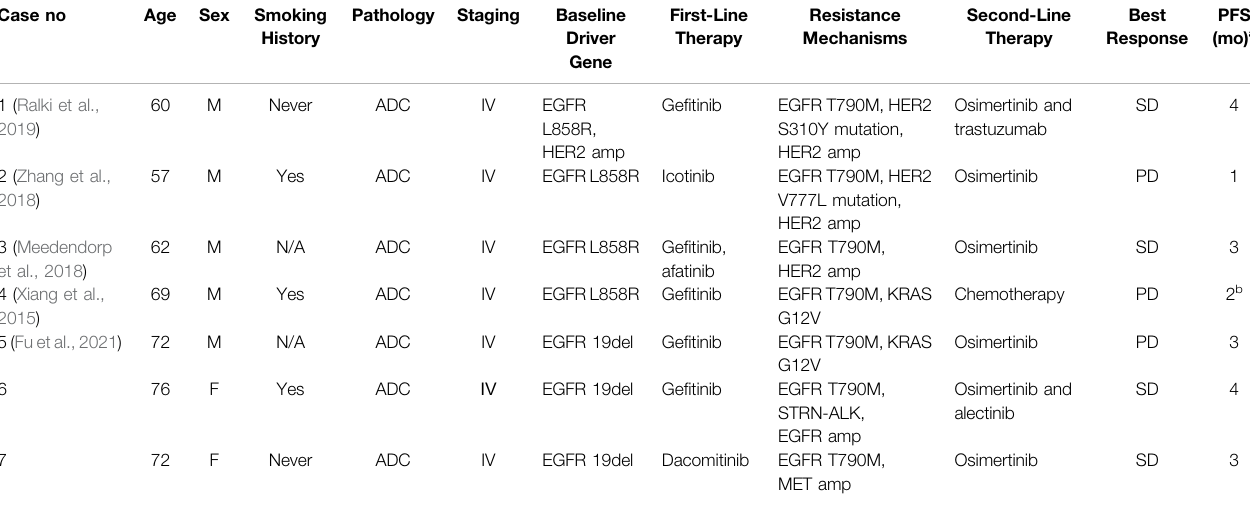
TABLE 1 | Clinicopathological characteristics of concurrent EGFR-T790M and driver gene-resistant NSCLC patients. Case no Age Sex Smoking